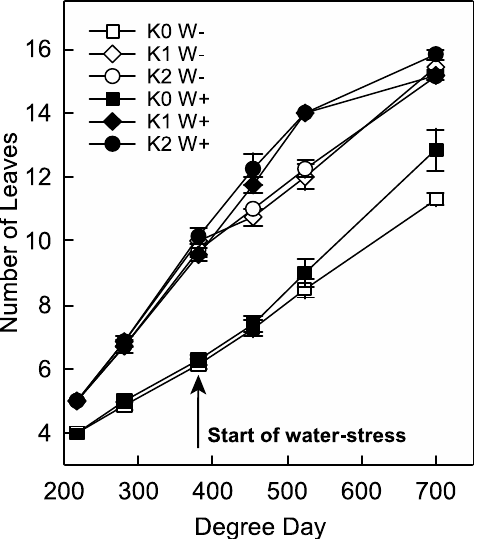
Figure 1. Number of leaves in relation to degree-days for well-watered (W+, black symbols) and water-stressed (W − , white symbols) corn plants ( n = 7 plants; error bars are standard errors) for three potassium levels (K0 = low, K1 = normal, K2 =